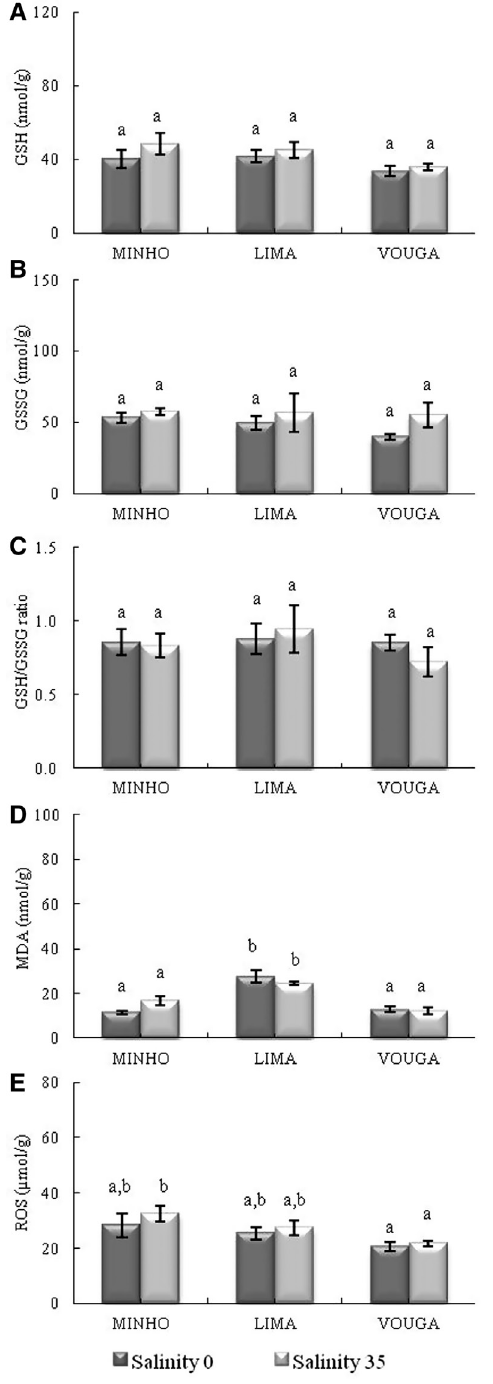
Figure 2: Mitochondrial contents in gills of (A) glutathione (GSH), (B) oxidized GSH (GSSG), (C) GSH/GSSG ratio, (D) malondialdehyde (MDA) and (E) reactive oxygen species (ROS) of sea lamprey juveniles kept for 30 days at 0 (gray bar) or gradually kept from 0 to 35 (white bar) salinity levels. Each bar represents the mean of five pools (3#) ± SEM. Bars marked with different letters are significantly different (p < 0.05).